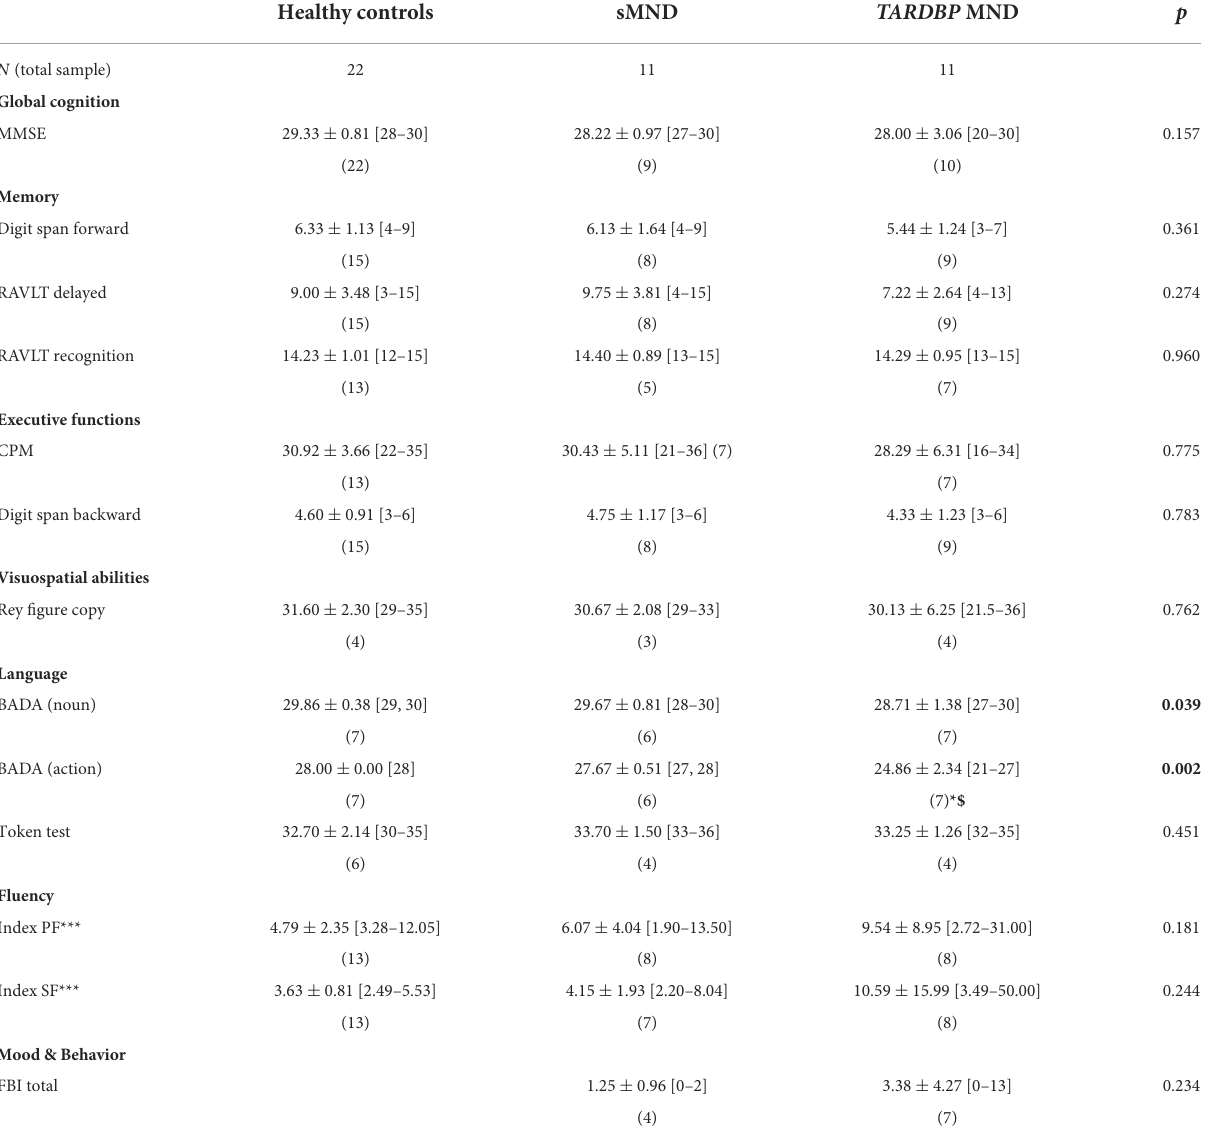
TABLE 3 Neuropsychological features of healthy controls and MND patients. Healthy controls sMND TARDBP MND